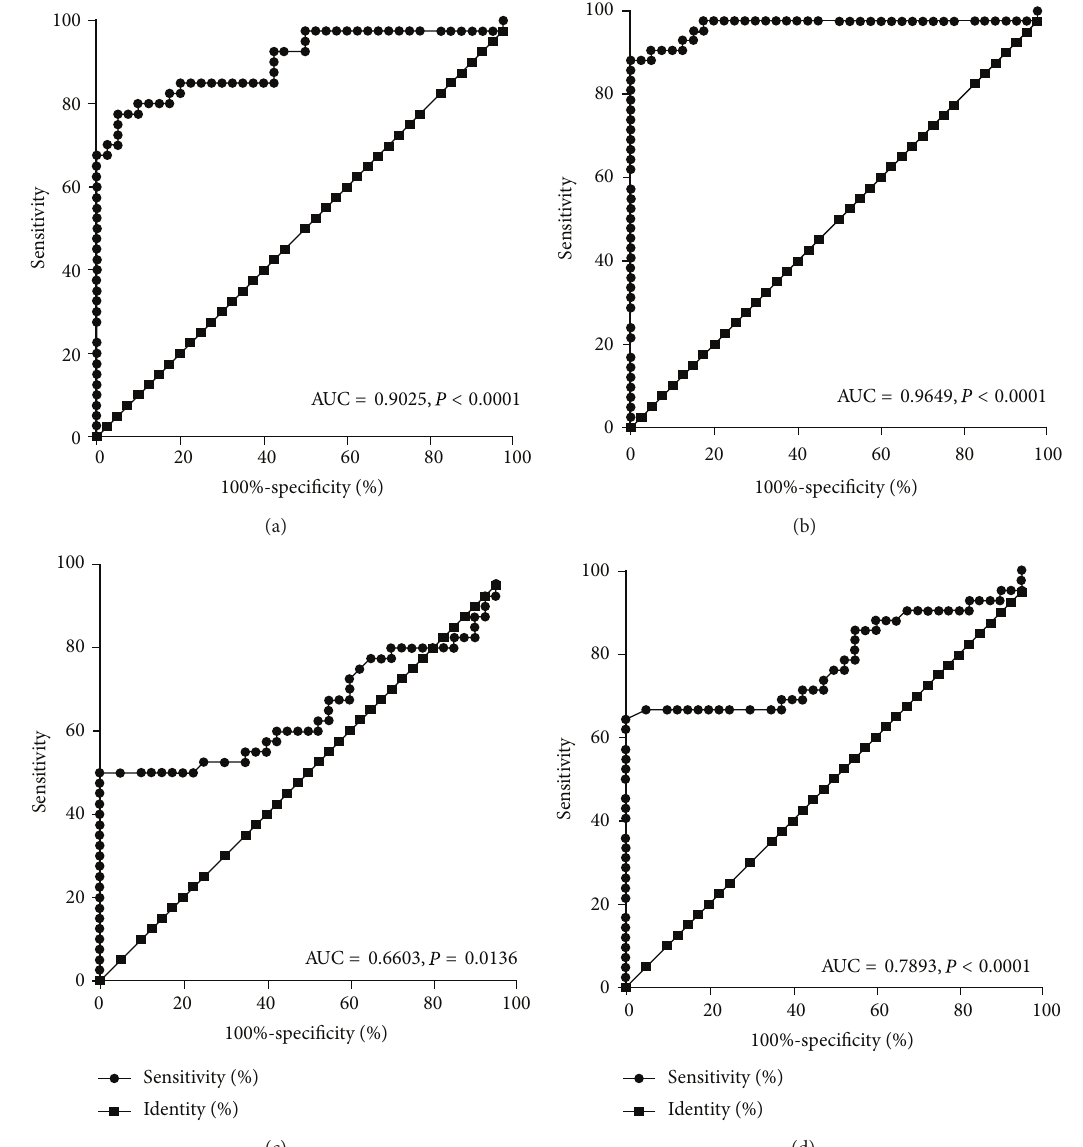
F 2: Receiver operating characteristic (ROC) curves indicate diagnostic value in differentiating active CD, UC from healthy controls. TRAF4 showed a signi�cantly diagnostic value in differentiating active CD patients from healthy controls (a) and active UC from healthy controls (b). TRAF6 also showed a signi�cantly diagnostic value in differentiating active CD (c) and UC (d) from healthy controls. �owever, the lower area under the curve (AUC) predicted a less diagnostic value than TRAF4 (c) and (d). Abbreviations: AUC: area under the